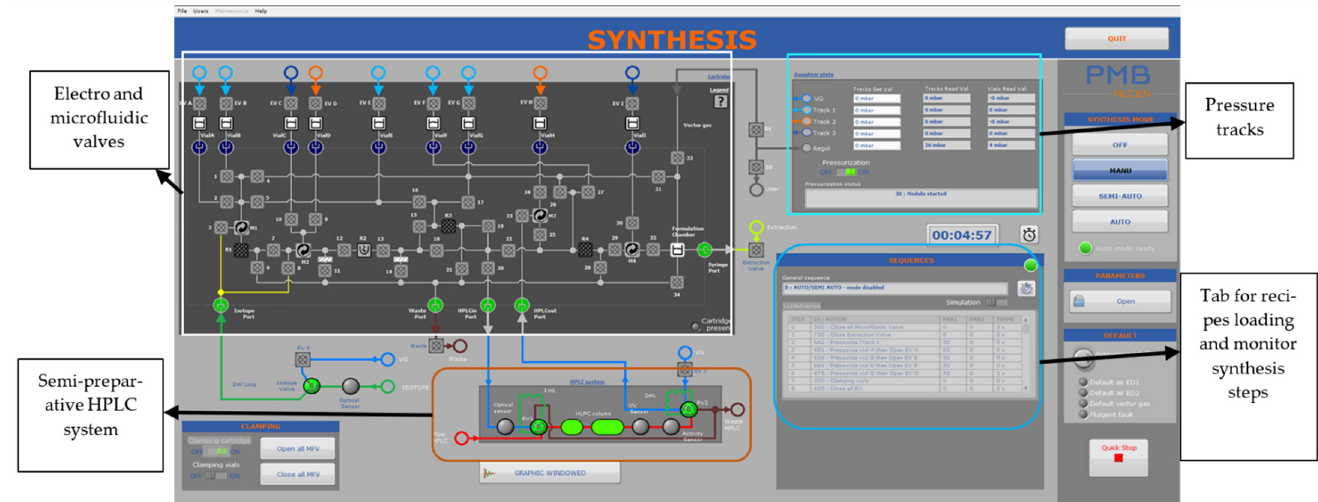
Figure 2. The detailed view of iMiDEV™ supervision software view (HMI).